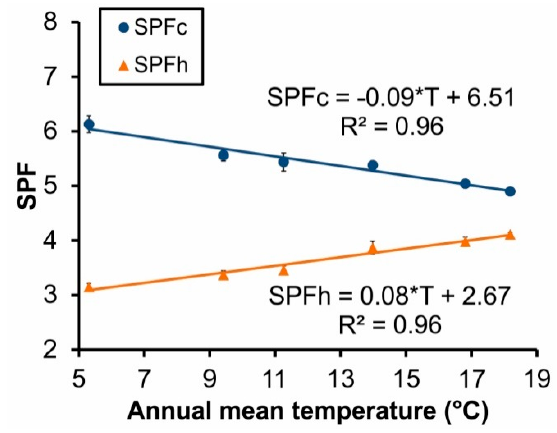
Figure 7. Heating and cooling SPF (Seasonal Performance Factor) vs. annual mean air temperature.